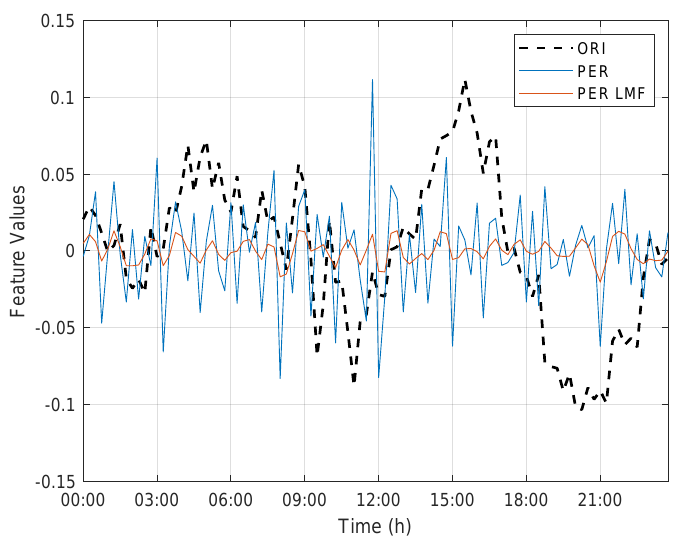
Figure 7. Results of approach 2.